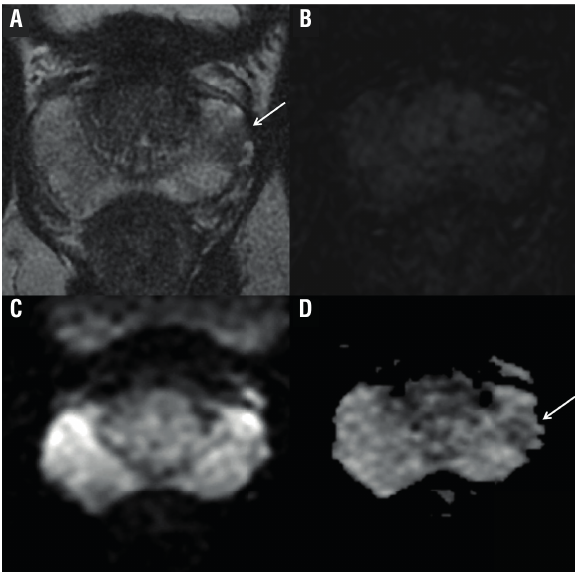
Figure 1 - A focal lesion was identifi ed by both radiologists on T2WI (a) in the prostate left middle third, but with slightly restricted diffusion (c, d) and negative perfusion (b). PI-RADS fi nal score 3 was assigned by the two readers. Pathological analysis revealed Gleason 8 in the right middle third and Gleason 7 in the left.